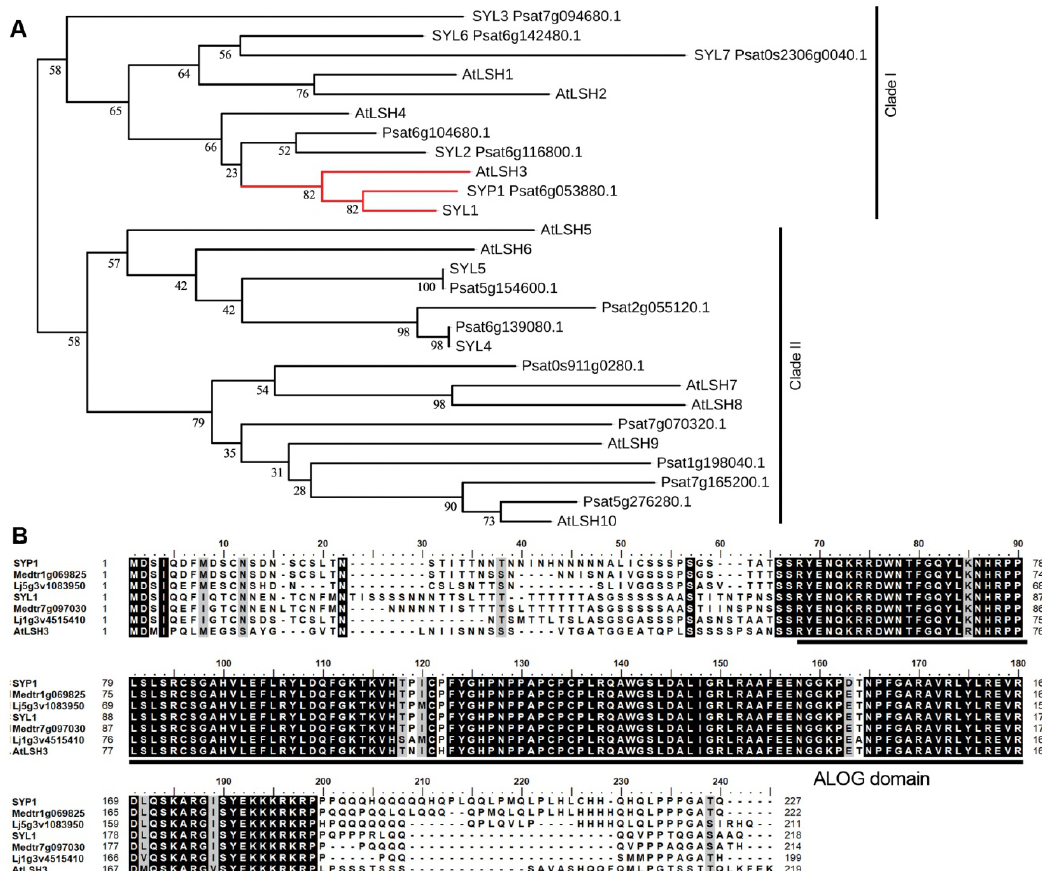
Figure 3. Phylogenetic analysis and sequence alignments of ALOG proteins. ( A ) The neighbor-joining tree of members of the ALOG gene family in pea and Arabidopsis. The bootstrapping value is located in each node as percentages along the branches. Red line indicates the branch including AtLSH3, SYP1 and SYL1. ( B ) The alignment of SYP1, SYL1, Medtr1g069825, Medtr7g097030, Lj5g3v1083950, Lj1g3v4515410, and AtLSH3 proteins using full-length amino acid sequences. The ALOG domain is indicated by a black line.